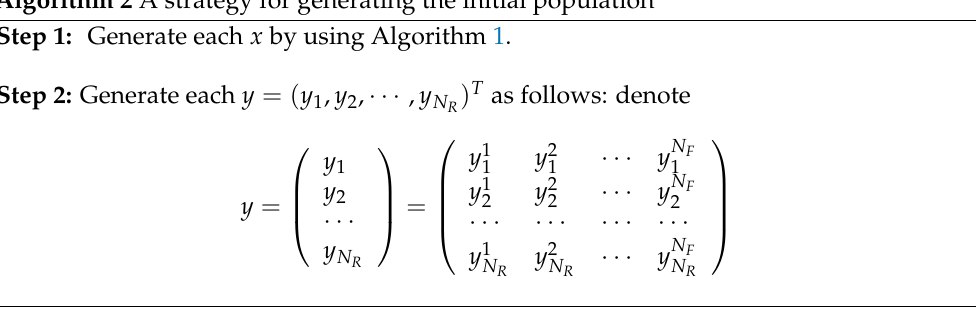
Algorithm 2 A strategy for generating the initial